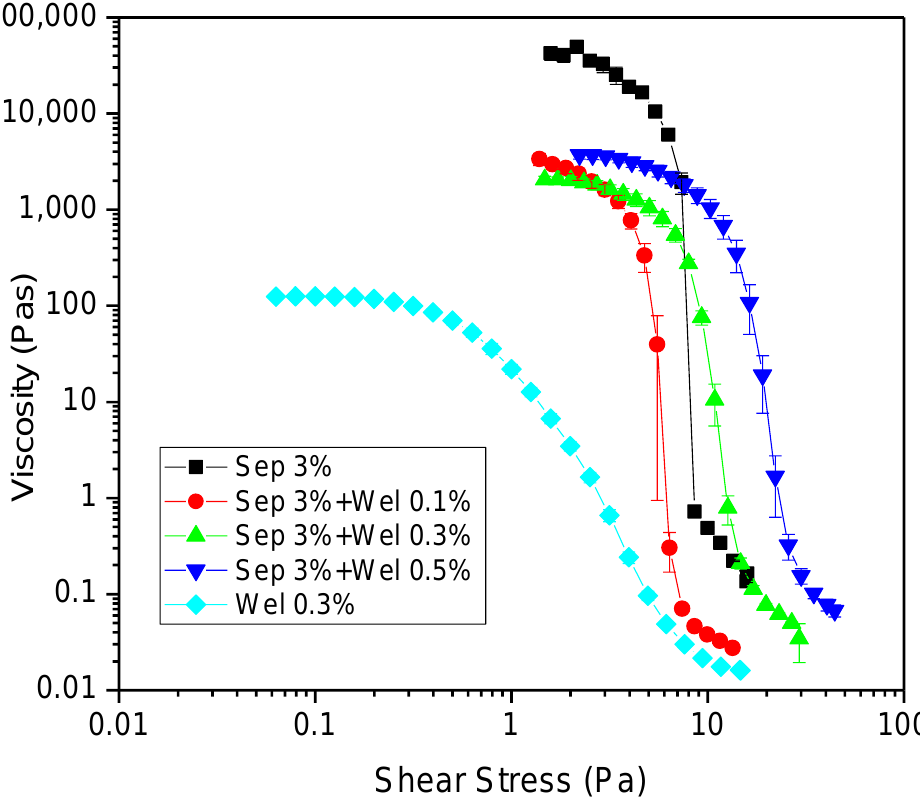
Figure 2. Flow curves of sepiolite gel (3% wt.)-based mixtures with different concentrations of welan gum (aging time = 24 h) at 20 °C. The 0.3% wt. welan gum system, for illustrative purposes, has been included. The error bars shown correspond to standard deviation.